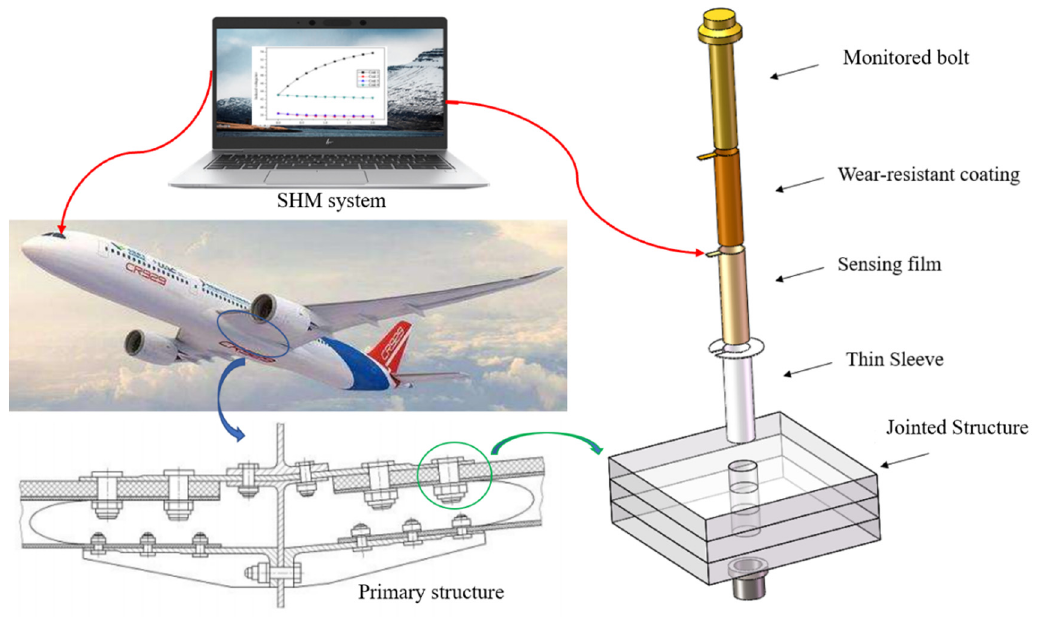
Figure 14. The structural health monitoring (SHM) system for monitoring the process of the bolt cracking.